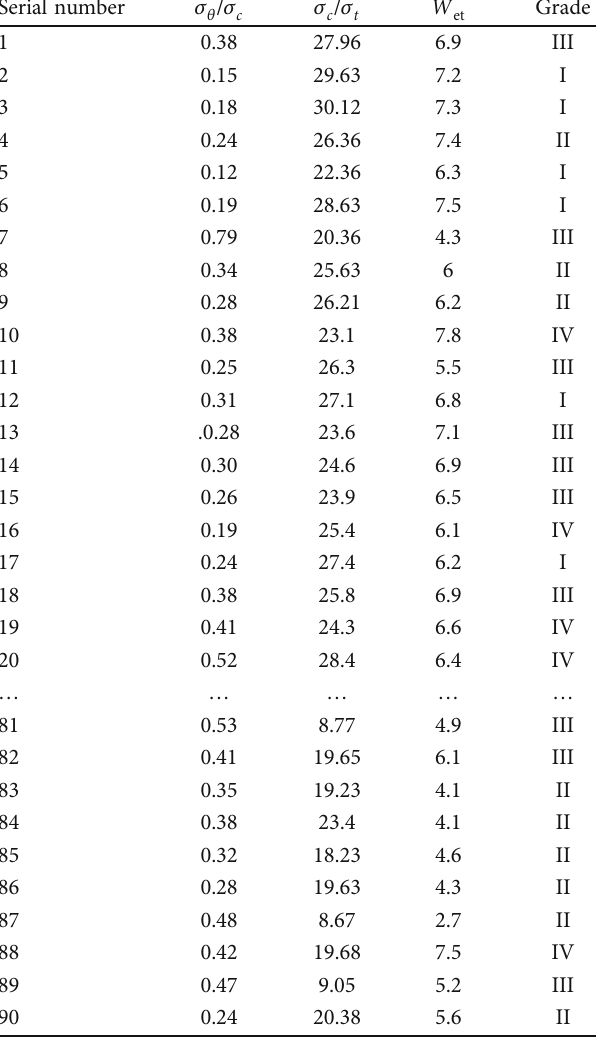
Table 1: Partial rockburst